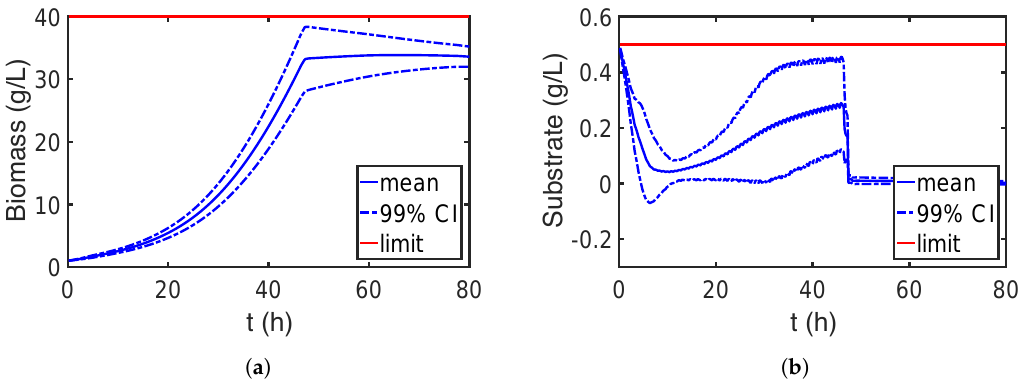
Figure 16. Evolution of the mean and 99% confidence interval (CI) of the ( a ) biomass and ( b ) substrate concentrations for the robust design of the fed-batch bioreactor, where the uncertain parameters are correlated. The feeding profile from the robust design with independent uncertain parameters is